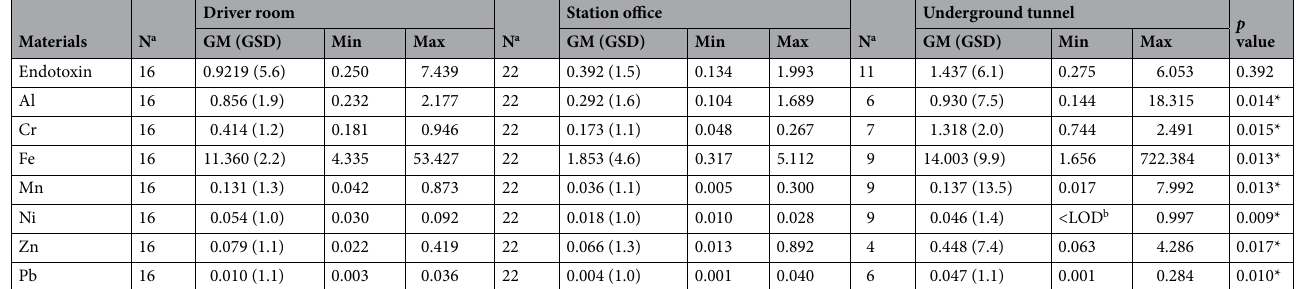
Table 3. Levels of airborne endotoxin (unit: EU/m 3 ) and heavy metals (Al, Cr, Fe, Mn, Ni, Zn, and Pb) (unit: µg/m 3 ) in different indoor places in subway environments. * p < 0.05. a Number of samples. b Limit of detection.